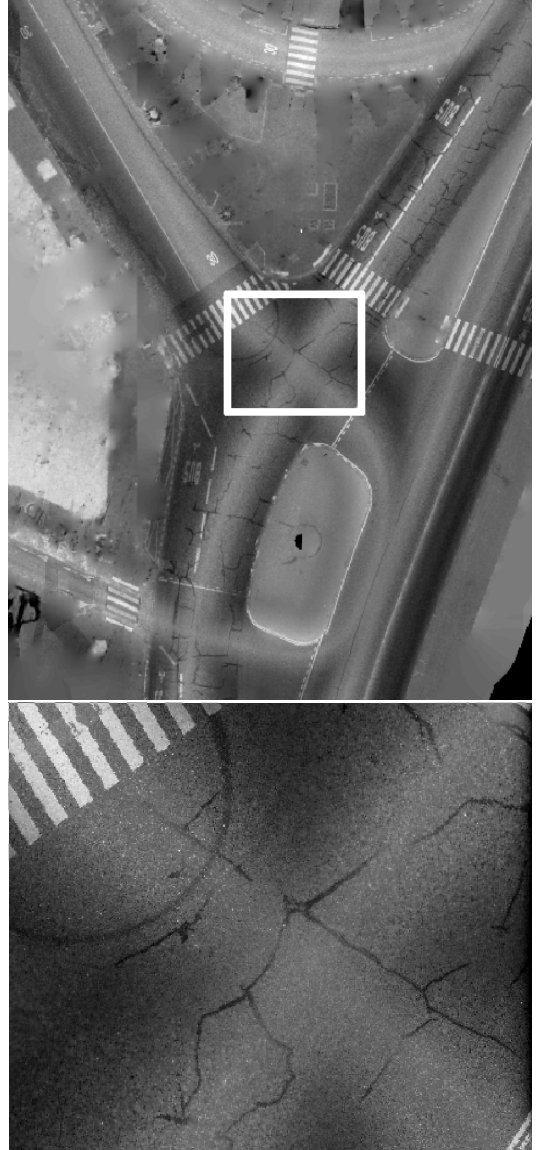
Figure 7: Blending result for reflectance image on an area around the tile which layers are displayed in Figures 4(b) and 5 and a close up near a trajectory crossing.